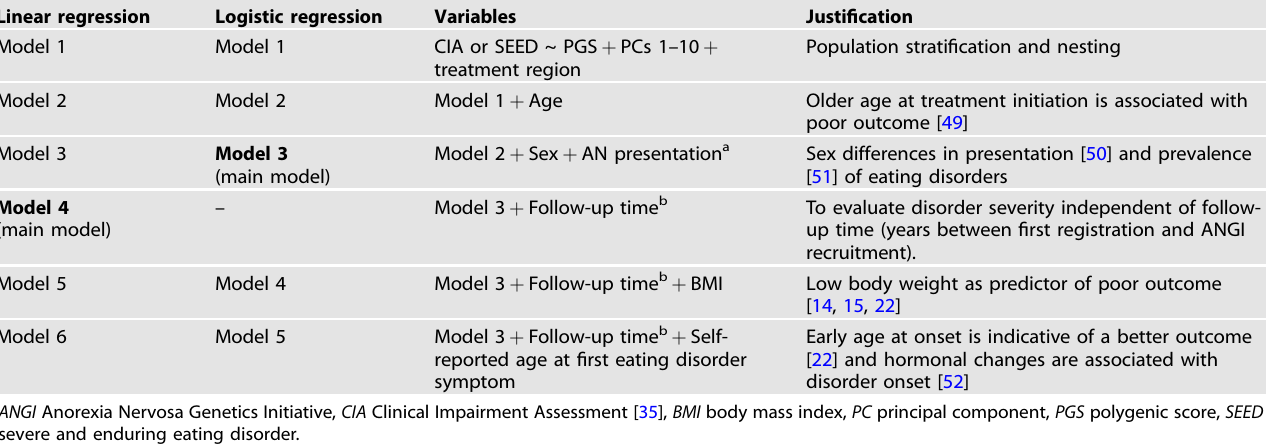
Table 3. Regression models fi